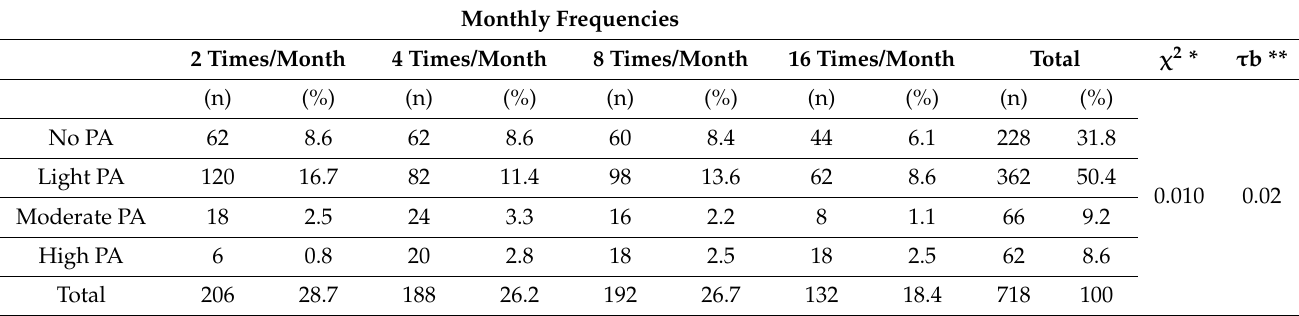
Table 7. Contingency table of physical activity levels and neck pain frequency.